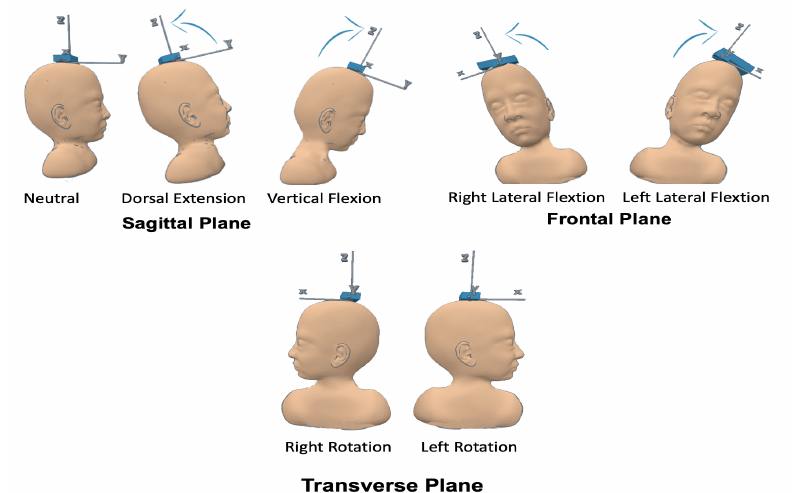
Figure 2. Head motion